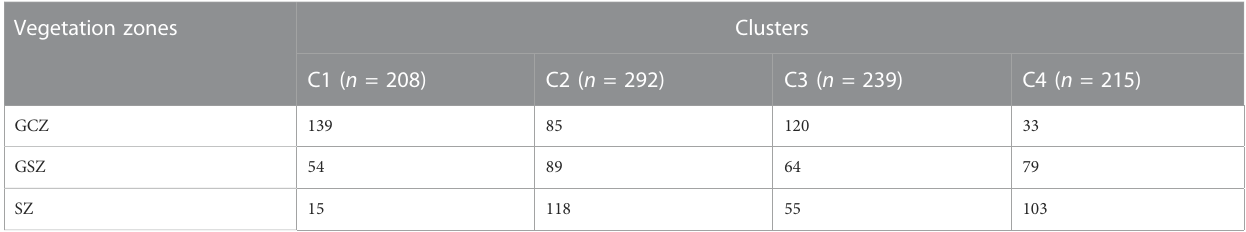
TABLE 4 Genetic clusters inferred for 954 goats from the three vegetation zones of Benin by applying the unsupervised discriminant analysis of principal components (DAPC). Vegetation